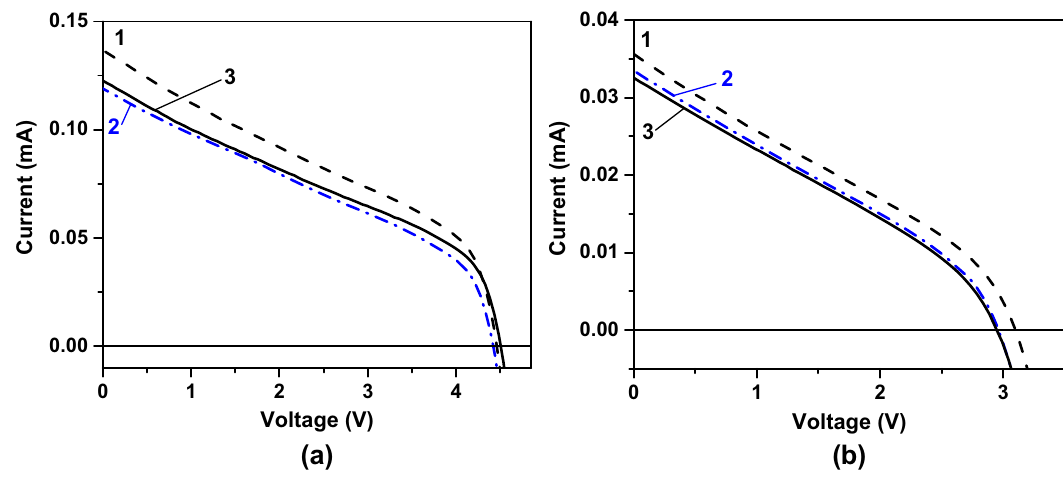
Figure 15: I – V characteristics of the PV set placed under the LSC and measuring the light passing through it. ( a ) LSC was illuminated with the solar simulator at 1.0 Sun. I – V characteristic 1 corresponds to the empty LSC; 2 – LSC fi lled with pure 1 - propanol, 3 – LSC fi lled with the NaY 0.83 F 4 :Yb 0.14 Er 0.03 nanocolloid in 1 - propanol. ( b ) LSC was illuminated with the 40 W light bulb. I – V characteristic 1 corresponds to